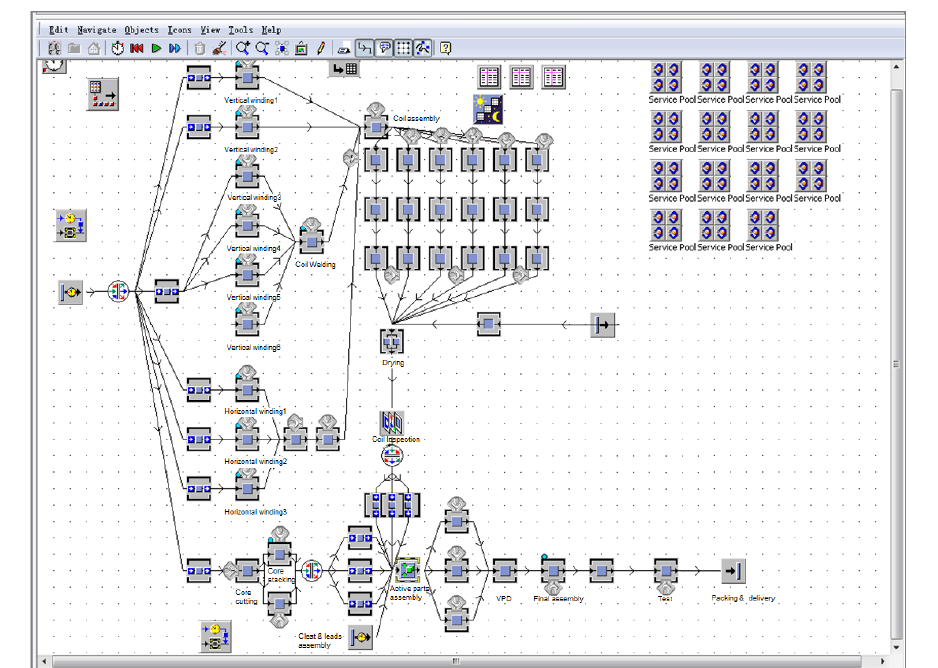
Fig. 8. Initial cloud simulation of transformer production system.